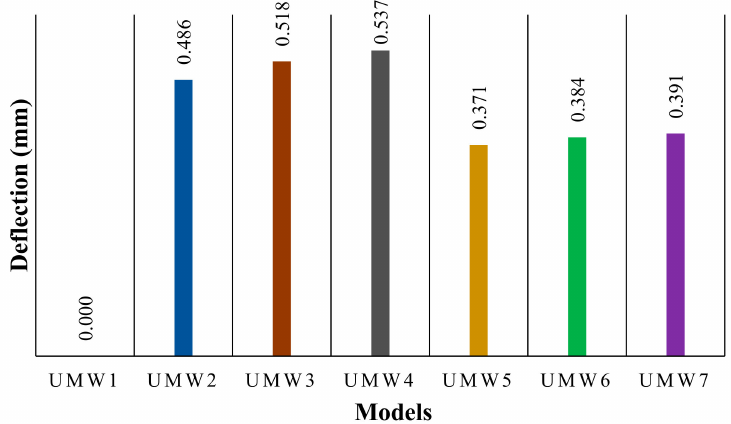
Figure 14. Average deflection of the top of the